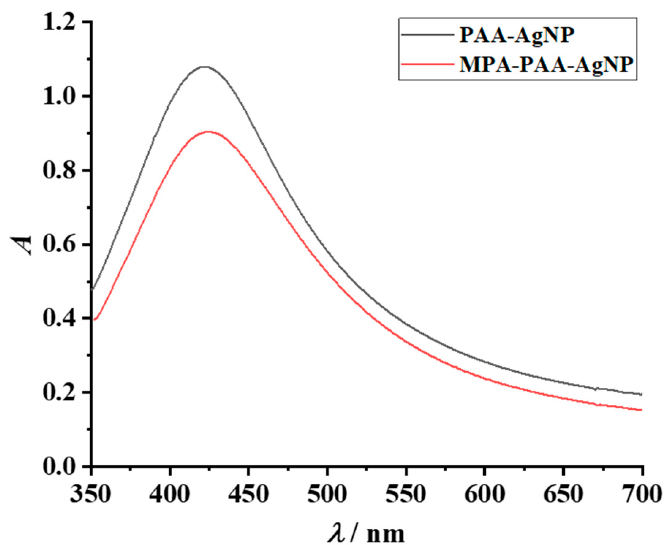
Figure 3. SPR bands for PAA-AgNPs and MPA-PAA-AgNPs, obtained immediately after synthesis with a specimen dilution of ϕ = 1:200.